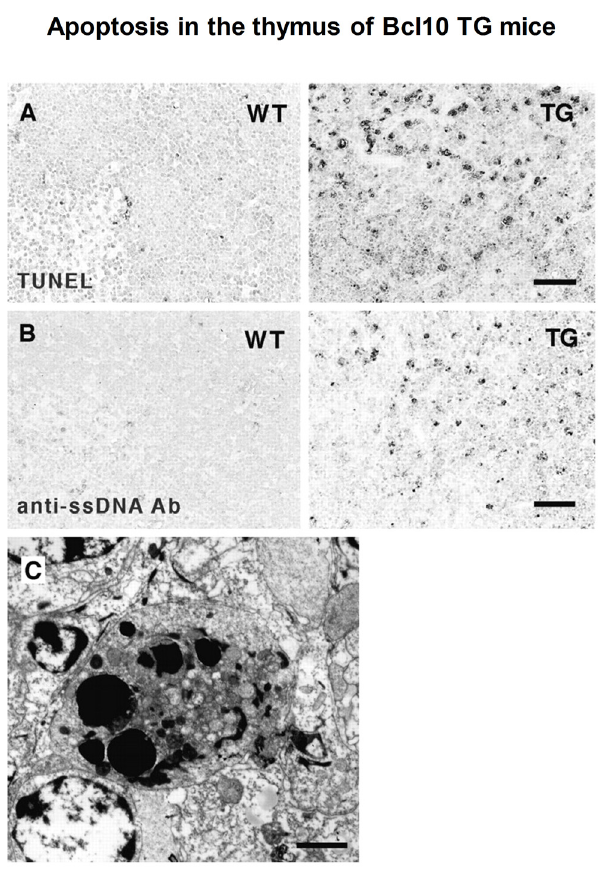
Figure 5. Different results leading to the same conclusion in one figure. In this single figure from article [24], results from three different assays, ‘‘TUNEL’’ ‘‘anti-ssDNA’’ and ‘‘electron microscopy’’ are depicted.